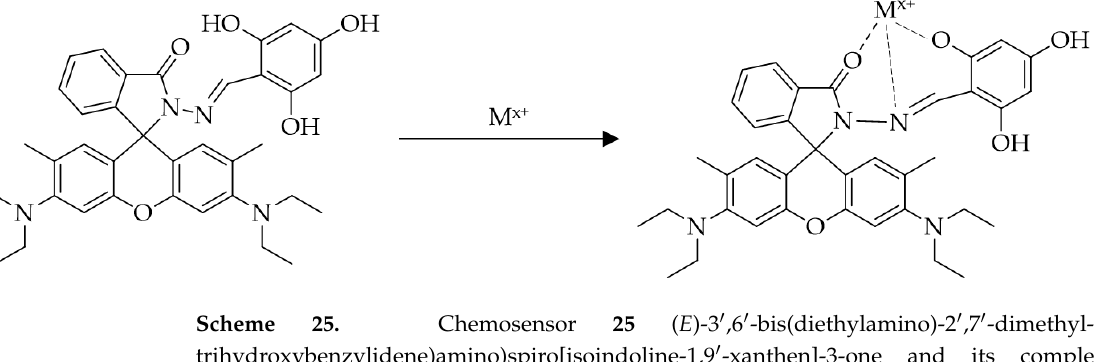
the target metal ion. Table 1. Basic quality assurance and analytical parameters for the analysis of metal ions. Sensing